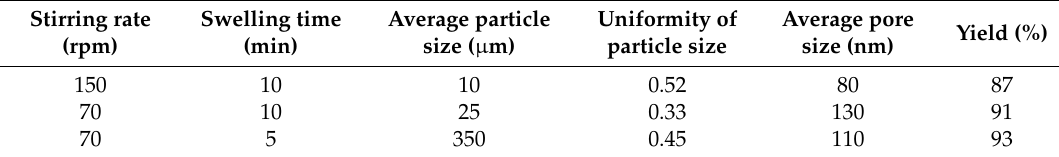
Figure 7. The photographs of the polymer microspheres of the ( a ) membrane emulsification (SEM ×500) and ( b ) size distribution (dispersed) .